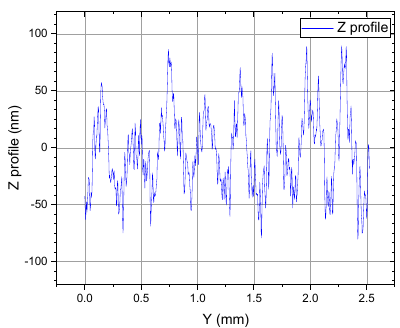
Figure 6. Two-dimensional contour curve in the feed direction.